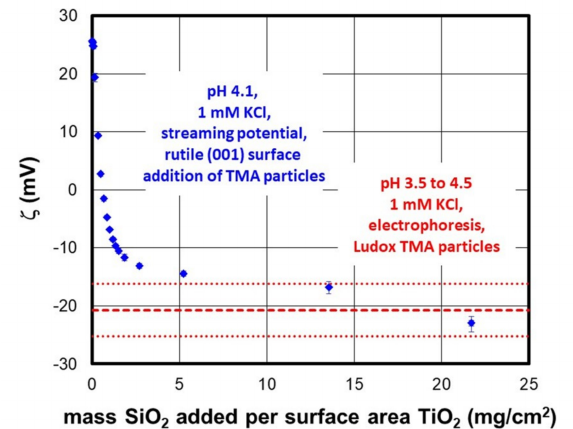
Figure 9. Zeta-potential of rutile (001) single crystals at pH 4.1, in 1 mM KCl, as a function of Ludox TMA solid concentration (blue symbols) and average zeta-potential of Ludox TMA nanoparticles (dotted line). The fine dotted lines show the three sigma limits of the repeated measurements on the